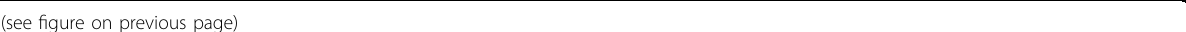
Fig. 7 USP39 facilitates ef fi cient splicing of the oncogenic transcription factor HMGA2. A Expression of individual HMGA2 transcript isoforms was analyzed using RNA-seq data for A2780 cells with USP39 knockdown (sh-USP39) and control cells ( n = 3 biologically independent samples). B Sashimi plot visualization of RNA-seq reads mapping to HMGA2 in A2780 cells in response to USP39 knockdown. C Splicing ef fi ciency analysis of HMGA2 at the 5 ′ and 3 ′ splicing sites upon USP39 depletion based on RNA-seq data. The red point represents HMGA2. Ef fi ciency 5 ′ = transread count/ 5 ′ intron end fi rst base coverage; Ef fi ciency 3 ′ = transread count/ 3 ′ intron end last base coverage. D Pre-mRNA/mRNA ratio in A2780 cells with USP39 overexpression or knockdown (sh-USP39) was measured by q-PCR. E Schematic diagram showing HMGA2 minigene constructs and alternative splicing types. F The expression of HMGA2 minigene transcripts in Hela cells transfected HMGA2 minigenes in combination with USP39 siRNAs was measured by semi-quantitative PCR. G IGV tracks displaying the coverage of HMGA2 by RIP-seq reads. H The interaction between USP39 and the HMGA2 transcript was validated by RIP-PCR of A2780 cells overexpressing FLAG-USP39. FLAG antibody was used for immunoprecipitation. U6snRNA served as a positive control and FOXM1 as a negative control ( n = 3 biologically independent samples). I RNA-pull down assay showing the interaction between the HMGA2 transcript and USP39 protein. HMGA2 site1 is an intronic sequence and the site2 sequence spanned an exon-intron junction. P value was obtained by Student ’ s t -test. Results represent the mean ± SD of three independent experiments. * P < 0.05, ** P < 0.01, *** P <